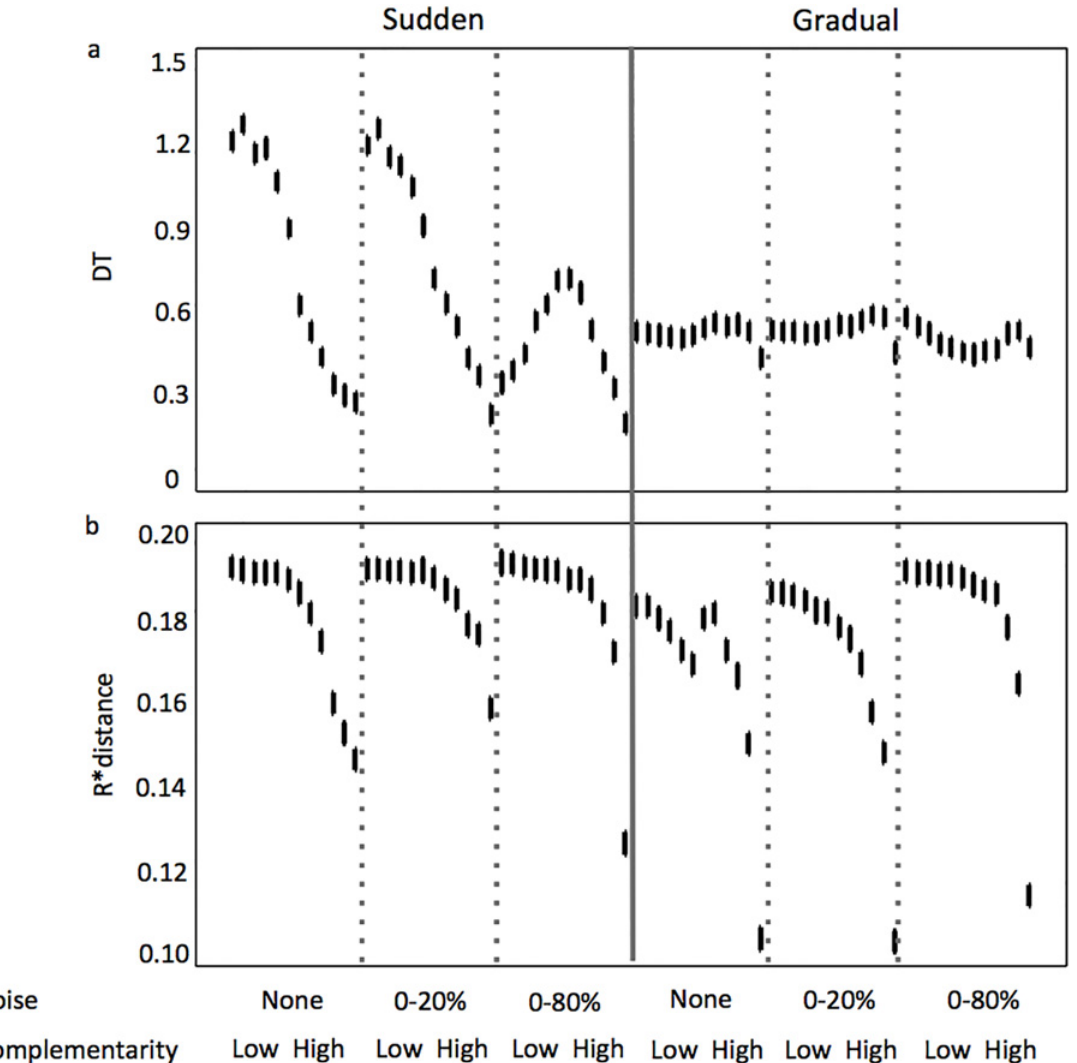
Fig 8. Variability of species interactions D T (a) and R * Distance (b) along a gradient of increasing complementarity in the assemblages and noise in resource concentration from the supply, when the reversal in resource supply concentrations is sudden and gradual. Error bars represent 95% confidence